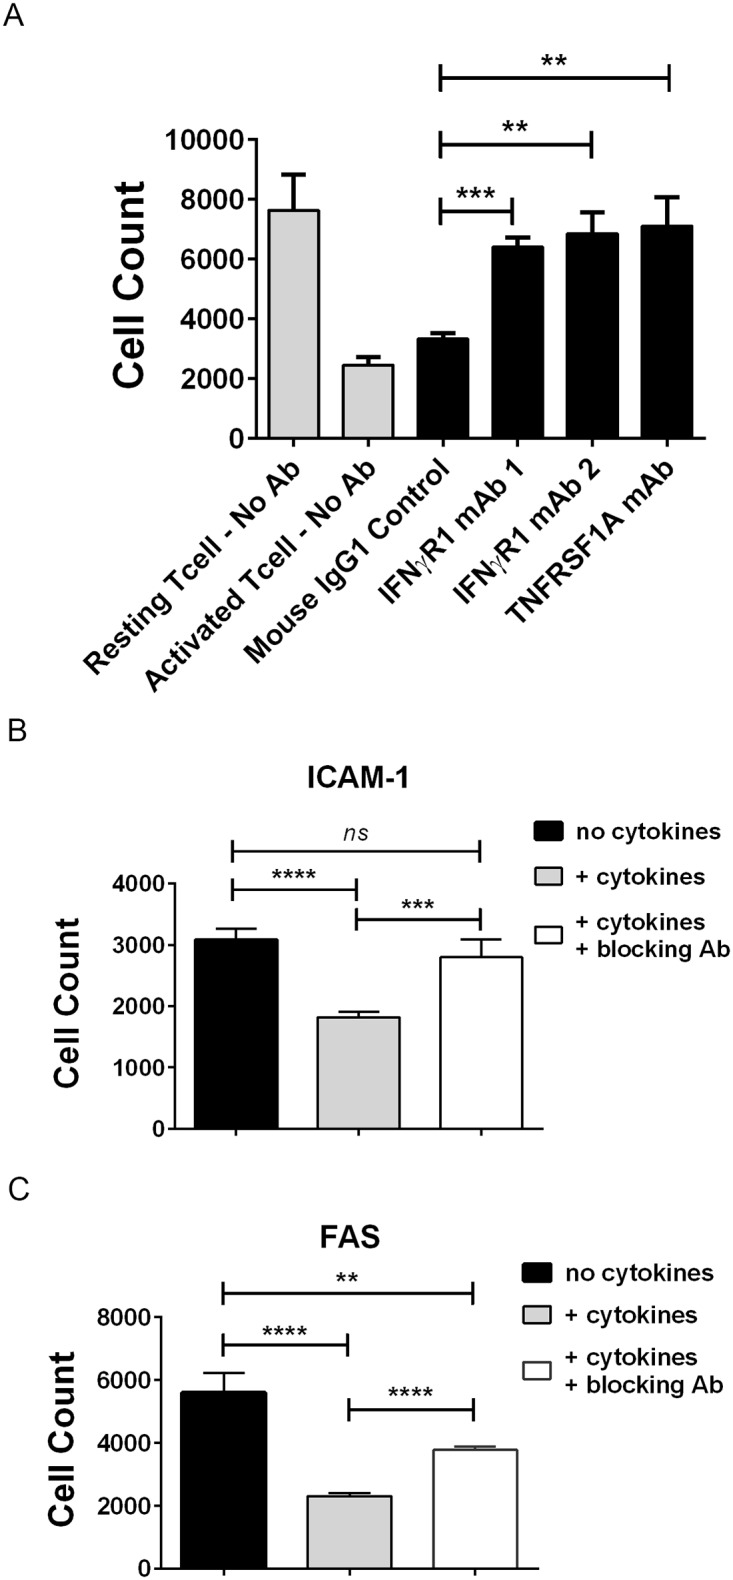
Blockade of IFNγ R1, TNFR1, ICAM-1 or FAS provided partial protection from BiTE®-mediated cytotoxicity.(A) SW620 cells were pretreated with either IFNγ R1- or TNFR1-blocking antibodies or mouse IgG1 control antibody at 2 μg/ml (final) for one hour prior to addition of resting T cells or BiTE®-activated T cells (E:T ratio 10:1) for 48 hours; N = 6, mean +/- sd. SW620 cells were pretreated with cytokines (5ng/ml IFNγ + 10ng/ml TNFα) for 18 hours to induce ICAM-1 and FAS, then incubated with (B) 5 μg/ml anti-ICAM-1 (final) or (C) 2.5 μg/ml anti-FAS (final) neutralizing antibodies (+ cytokines + blocking Ab) or control antibody (no cytokines and + cytokines) for one hour followed by addition of BiTE®-activated T cells (E:T ratio 10:1) for 24 hours. Cell count was determined by imaging; N = 4, mean +/- sd. Significance values: ns, P > 0.05; *P < 0.05; **P < 0.01; ***P < 0.001; ****P < 0.0001.